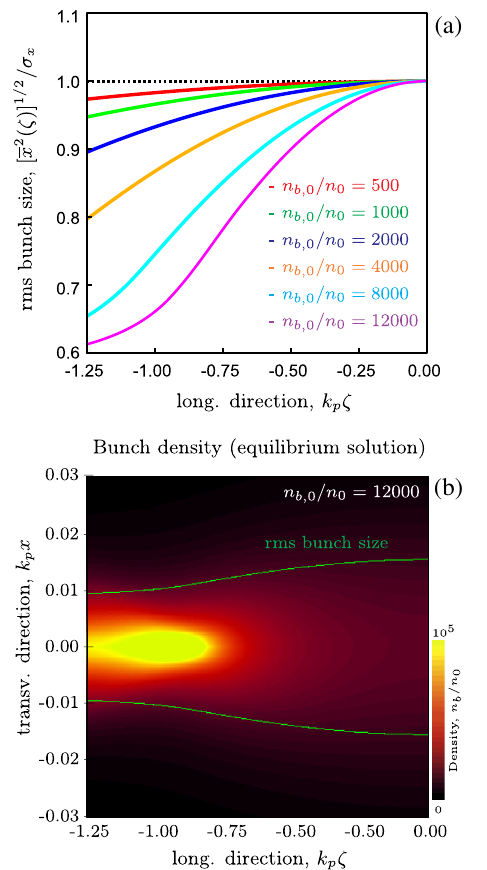
FIG. 4. (a) Normalized rms bunch size measured along the bunch, ½ ¯ x 2 ð ζ Þ(cid:2) 1 = 2 = σ , for the matched equilibrium solution x obtained for different values of the bunch peak density. (b) 2D snapshot of the bunch density for the equilibrium solution =n 0 ≃ 12 000 . All the other bunch and plasma obtained for n b; 0 parameters are the same as in Fig.